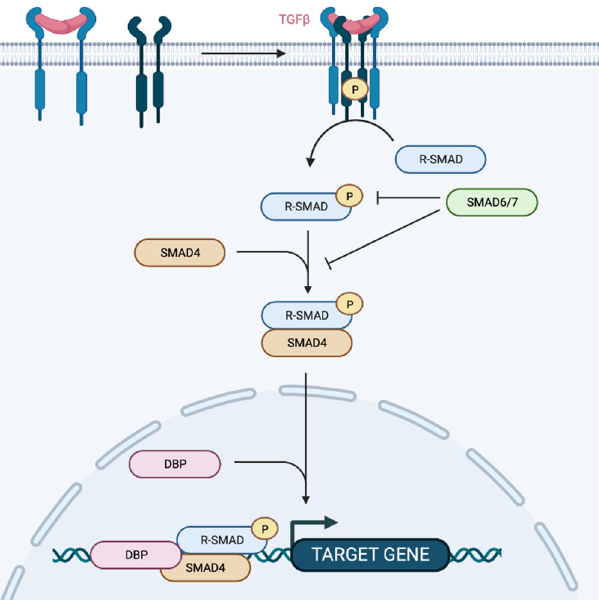
Figure 5. TGF β pathway. Binding of TGF β to T β RII and recruitment of T β RI leads to the formation of a receptor complex and the phosphorylation of T β RI. Further phosphorylation of receptor-regulator SMADs (R-SMADs) will allow recruitment and association to SMAD4 and translocation into the nucleus to associate with DNA-binding partners to activate target gene transcription. SMAD6 and SMAD7 interfere with the TGF β pathway.